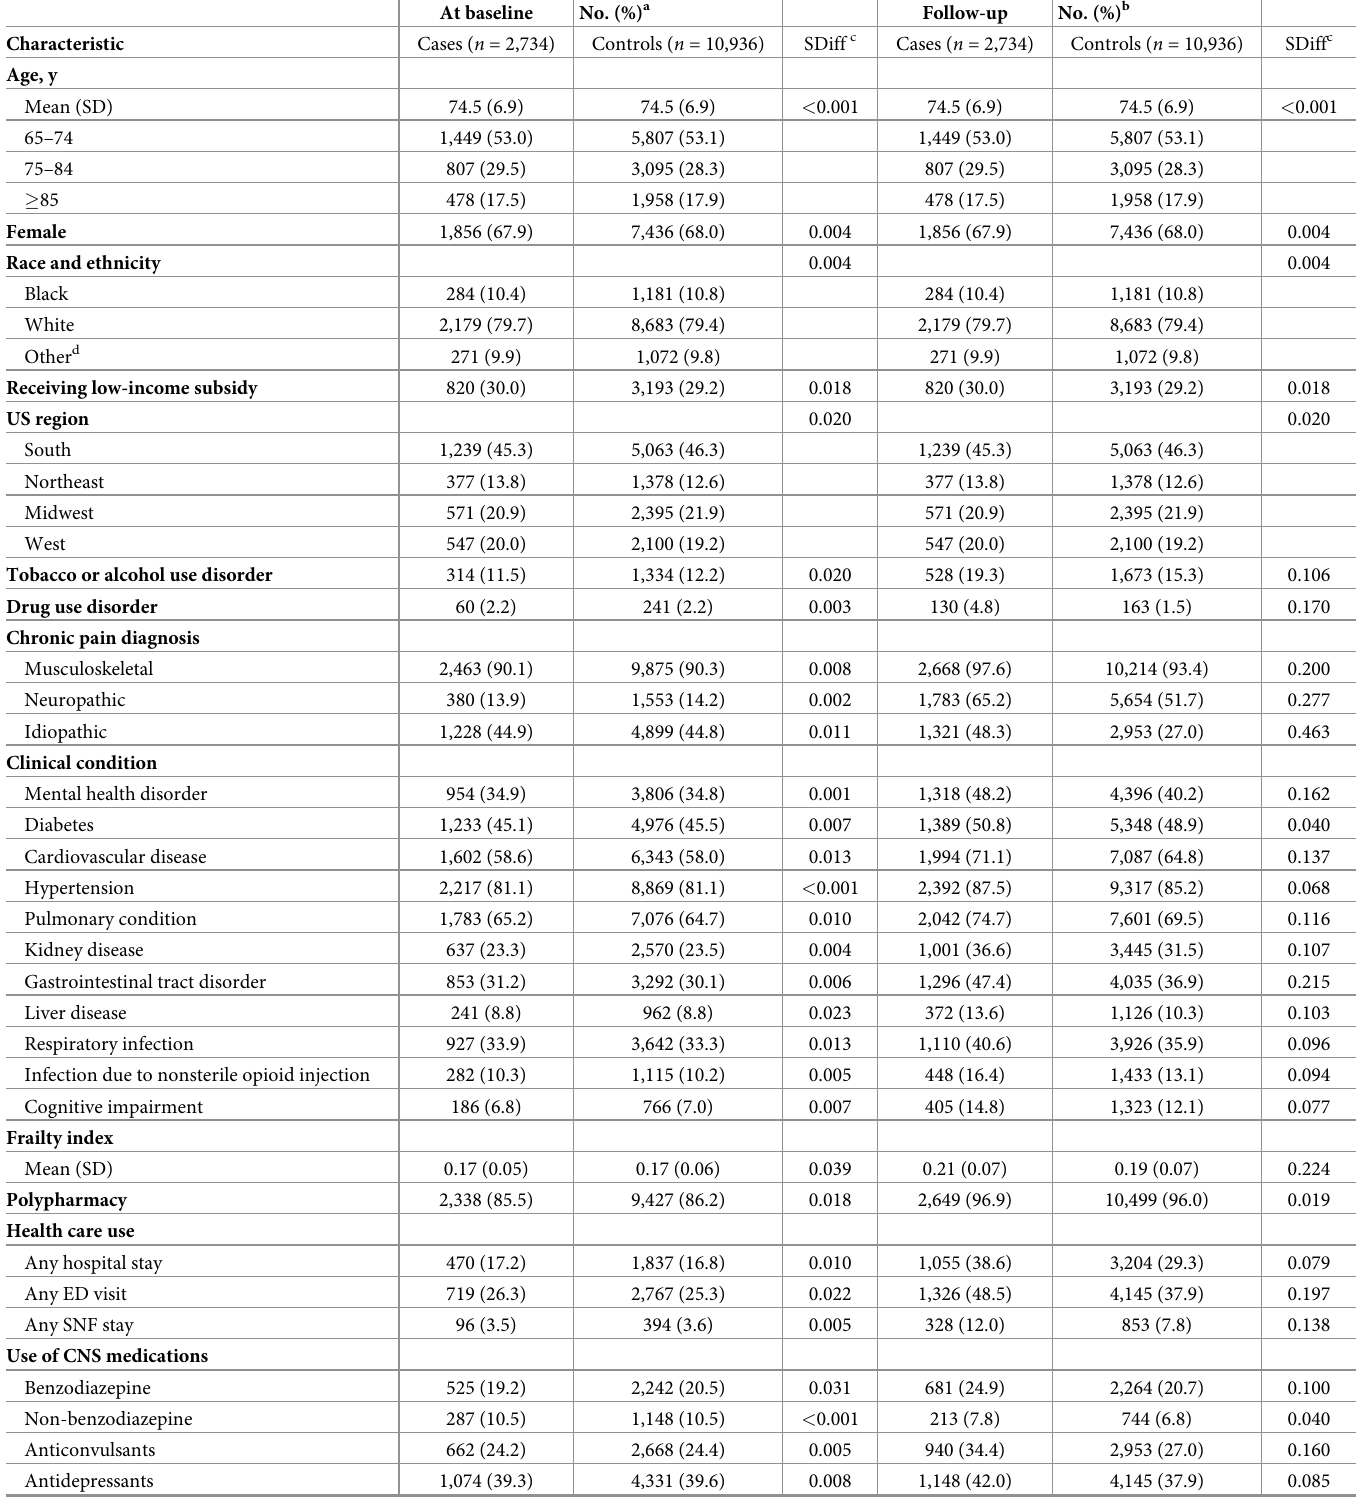
Table 1. Clinical and demographic characteristics of case patients and matched